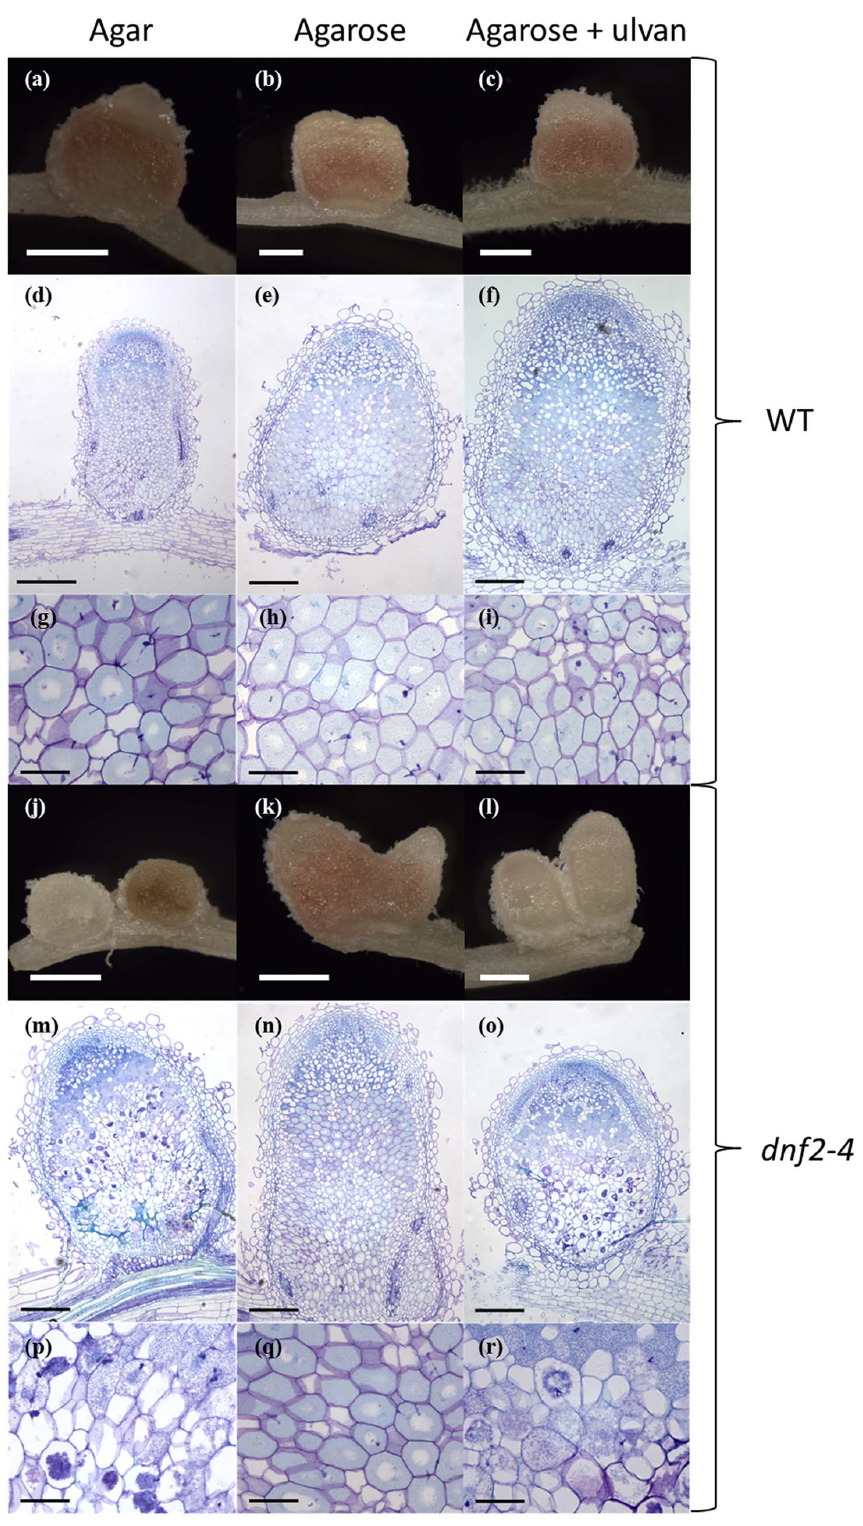
Figure 2. Plant growth conditions impact the dnf2 phenotype. Nodules were harvested 18 days post inoculation with Rm41. a-i, Wild-type nodules. j-r, dnf2–4 nodules. Left panels, middle panels and right panels represent nodules grown on agar-, agarose- and agarose-based BNM supplemented with 1% ulvan respectively. Panels a, b, c, j, k and l (scale bars 500 m m) illustrate whole nodules, panels d, e, f, m, n and o (scale bars 200 m m except for d 500 m m) are thin sections of whole nodules and panels g, h, i, p, q, r (scale bars 50 m m) are enlargement of the zone III of panels d, e, f, m, n and o, respectively.